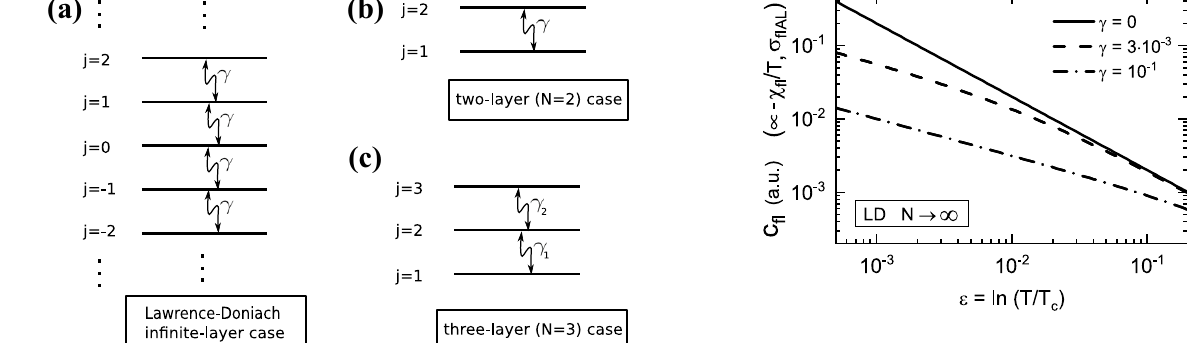
Fig. 2 Fluctuation specific heat c fl from the well-known GGL-LD predictions for superconductors composed of an infinite number of parallel 2D planes, as a function of the reduced temperature 𝜀 and for different values of the Josephson-coupling constant 𝛾 between adjacent layers. (As a reference, for optimally-doped cuprates of the YBaCuO family values 𝛾 ≃ 0.001 ∼ 0.1 are usually proposed [11– 13]). The c fl is given in arbitrary units, and is proportional to the also observables − 𝜒 fl ∕ T and 𝜎 flAL (see main text for details). The figure illustrates that when 𝜀 ≪ 𝛾 the c fl behaves as in a 3D system (somewhat decreased amplitude and log-log slope − 1 ∕ 2 ) while if 𝜀 ≫ 𝛾 it displays a 2D behaviour (log-log slope − 1 ). See also Fig. 3